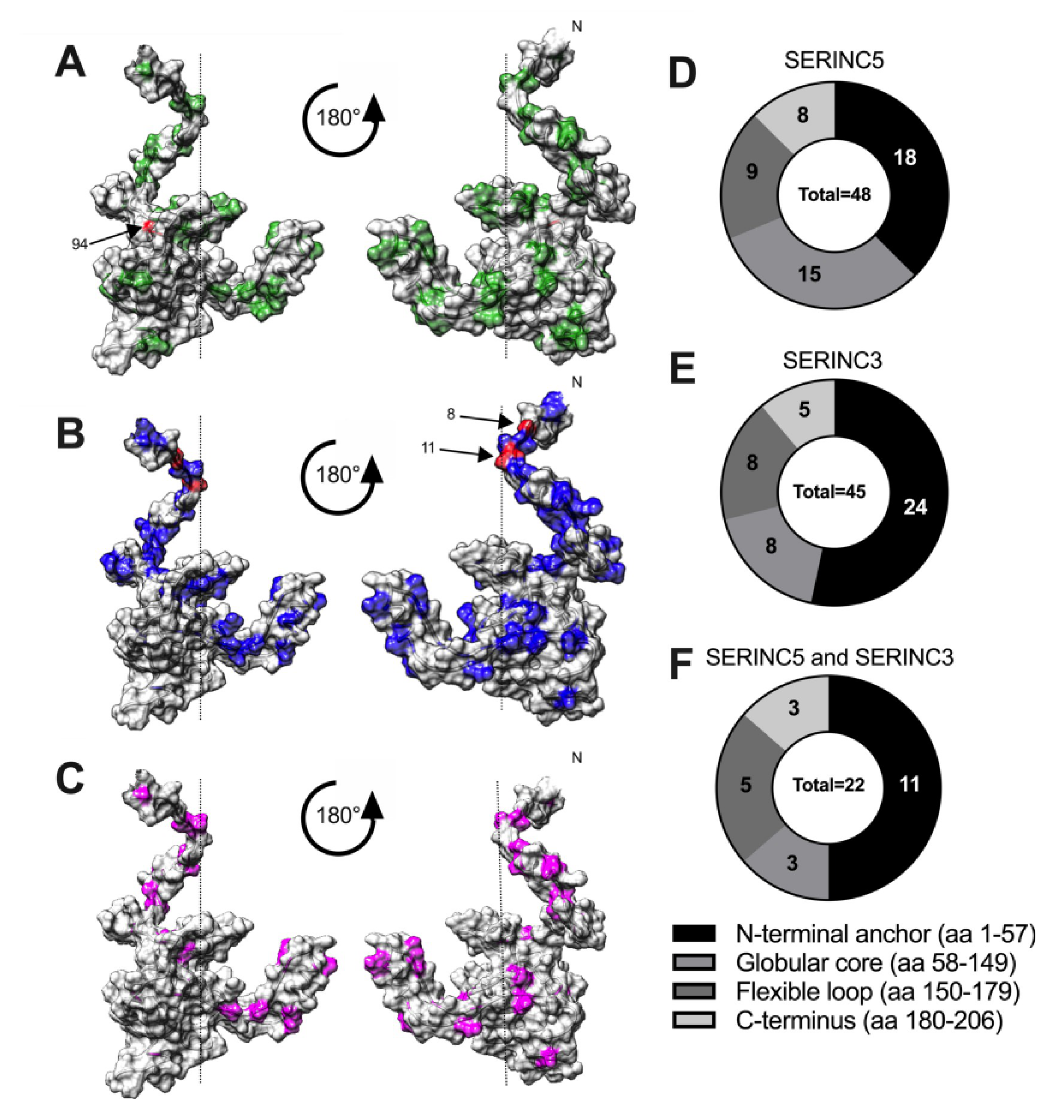
Fig 3. Structural distribution of Nef residues associated with SERINC antagonism. (A, B, C) The location of Nef polymorphisms associated with internalization of SERINC5 (A , green ) , SERINC3 (B , blue ) , or both proteins (C , magenta ) are indicated on a composite structural model of HIV Nef (based on PDB 2NEF and 1QA5) (Lamers, PLoS One 2011). Residue 94 (SERINC5, panel A ) and residues 8 and 11 (SERINC3, panel B ) are highlighted in red. (D, E, F) The distribution of natural polymorphisms associated with internalization of SERINC5 (n = 48) (D) , SERINC3 (n = 45) (E) or both proteins (n = 22) (F) among Nef’s major functional domains is illustrated.